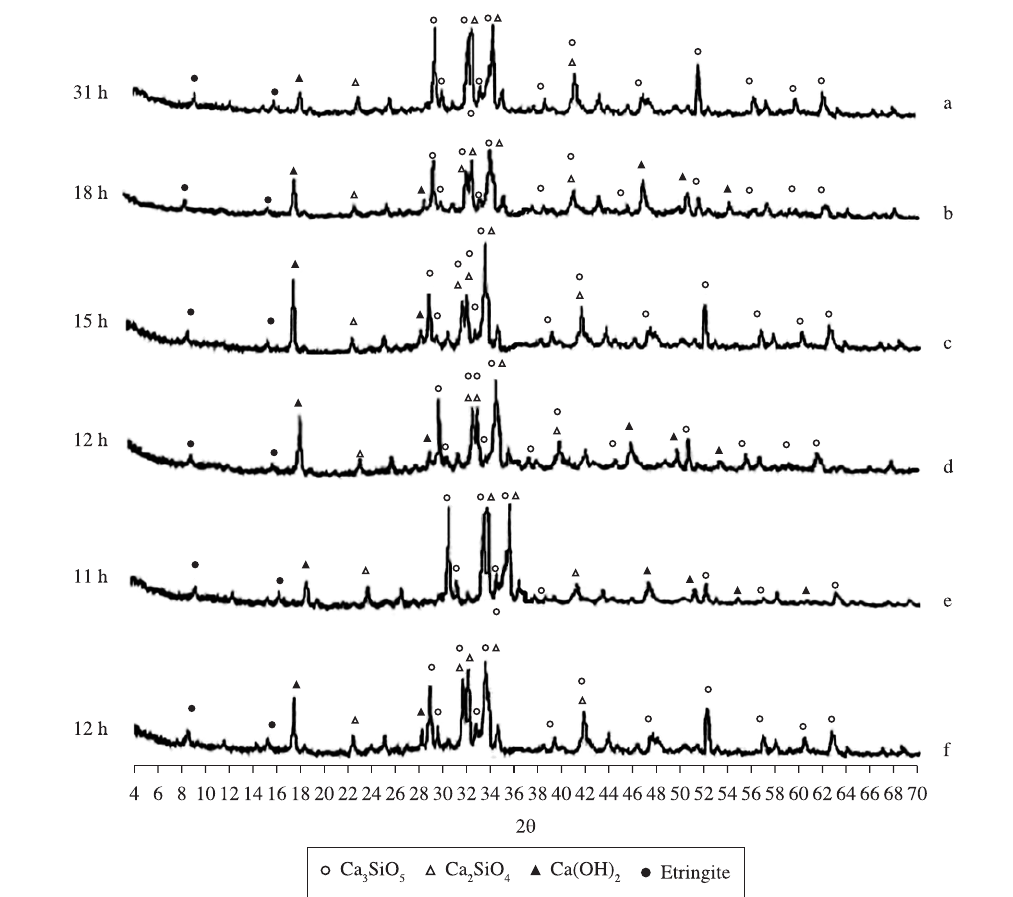
Figure 3. XRD results indicating the formation of hydrated products for different N-SCC specimens: a) C0-SCC1; b) N1-SCC1; c) N2-SCC1; d) N3-SCC1; e) N4-SCC1; and f) N5-SCC1.